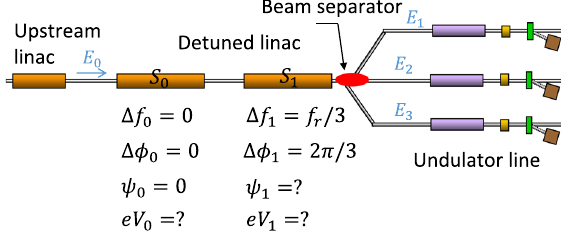
FIG. 3. Layout of the SRF linac to support two undulator lines with off-frequency detune method.